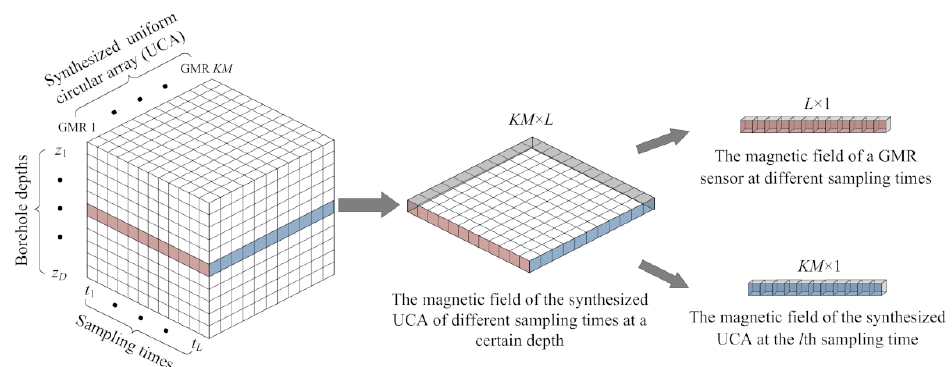
Figure 5. Three dimensional data structure of the synthesized